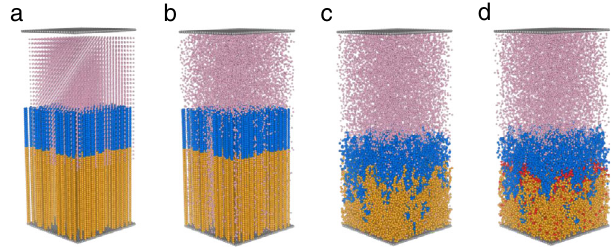
Fig. 3 DPD simulating the conformational evolution and uranium adsorption process of PAO m - b -PPEGMA n in water. a Initial state. b Diffusion of uranyl ions. c Conformational adjustment. d Occurrence of